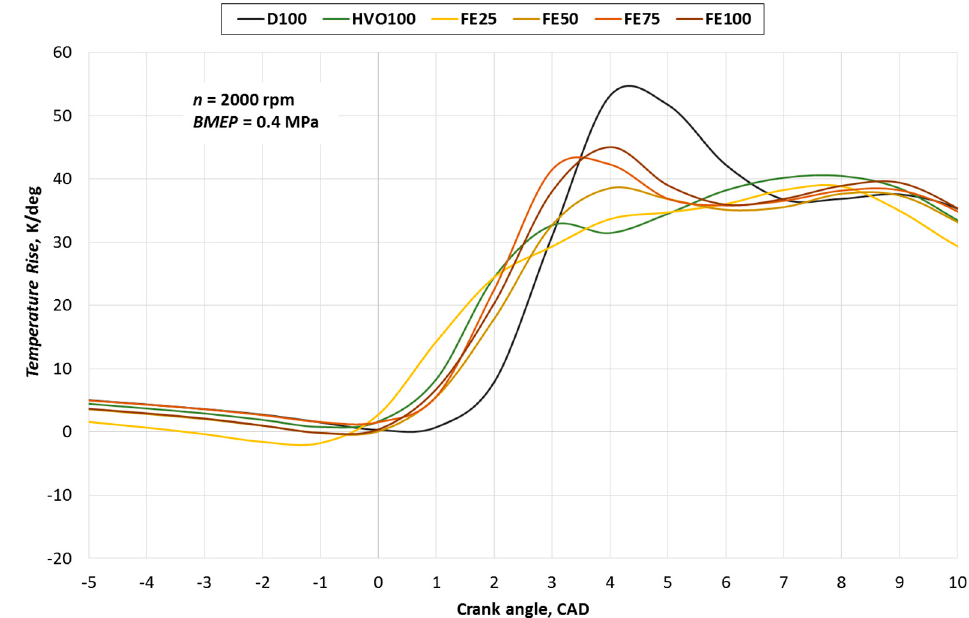
Figure 3. Temperature rise in the cylinder depending on the CAD.